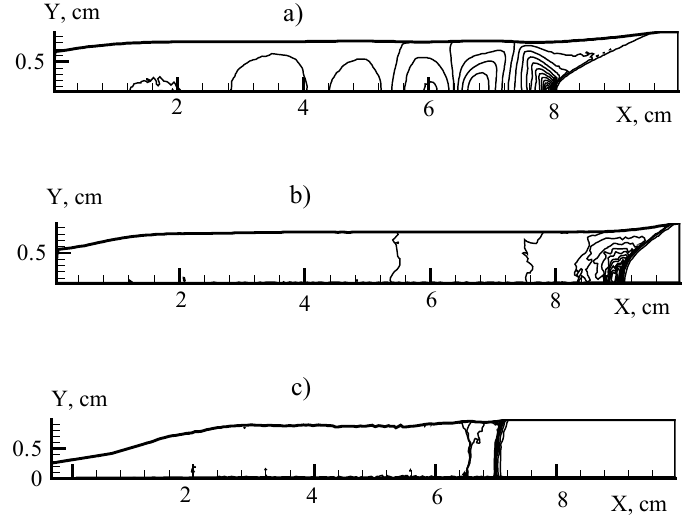
Figure 16: Pressure isolines: a) detonation velocity = 7 D km/s; b) detonation velocity = 5 D km/s; c) detonation velocity = 3 D km/s.